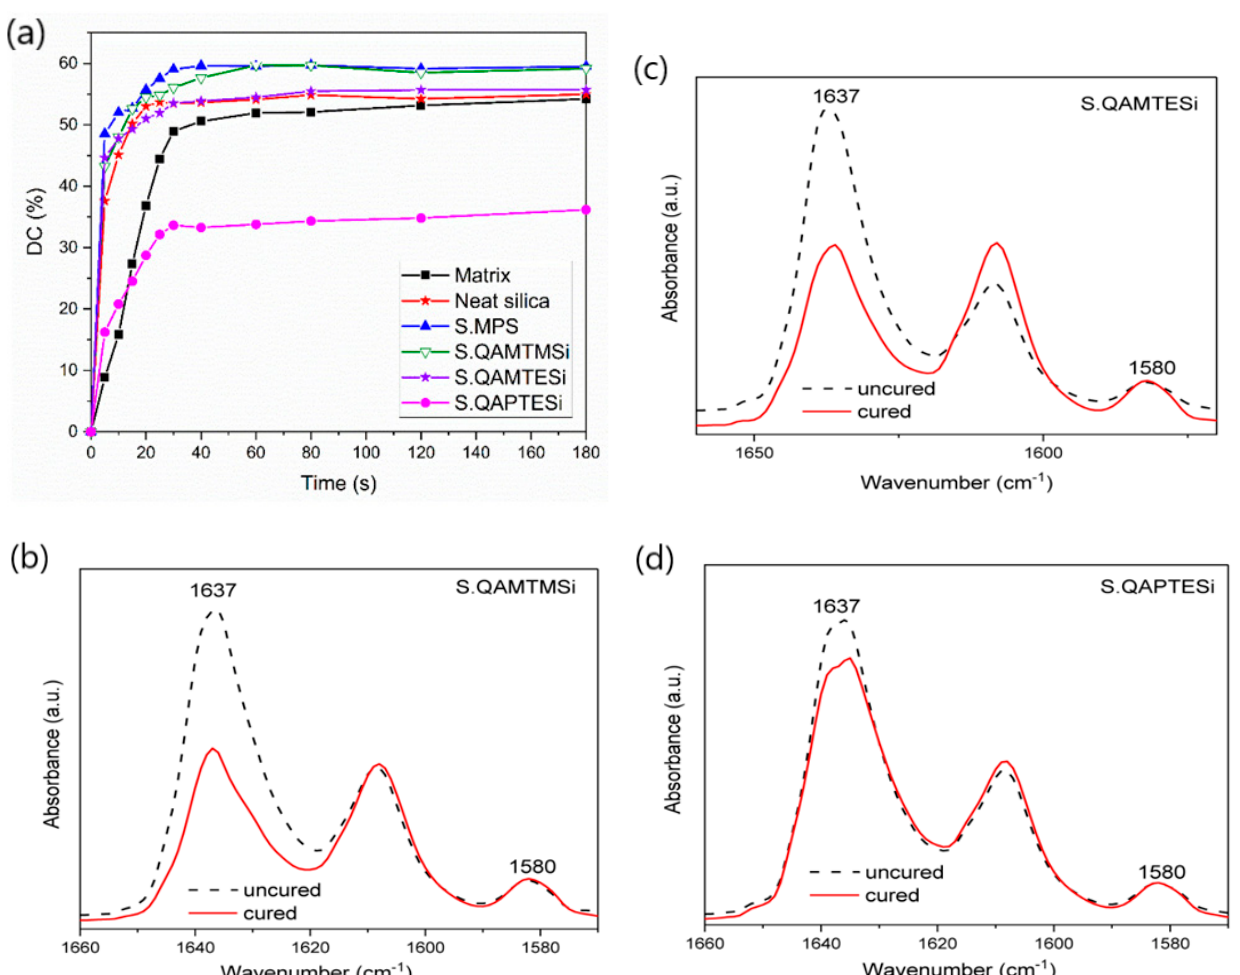
Figure 6. ( a ) Degree of conversion (DC%) versus curing time for the Bis-GMA/TEGDMA matrix and the experimental dental nanocomposite resins filled with 22 wt% of different type of silica nanoparicles. FTIR spectra with measured peak areas (1637 and 1580 cm − 1 ) used to calculate the percent degree of conversion (DC%) for uncured and cured composites filled with: ( b ) S.QAMTMSi; ( c ) S.QAMTESi; ( d ) S.QAPTESi nanocomposites.